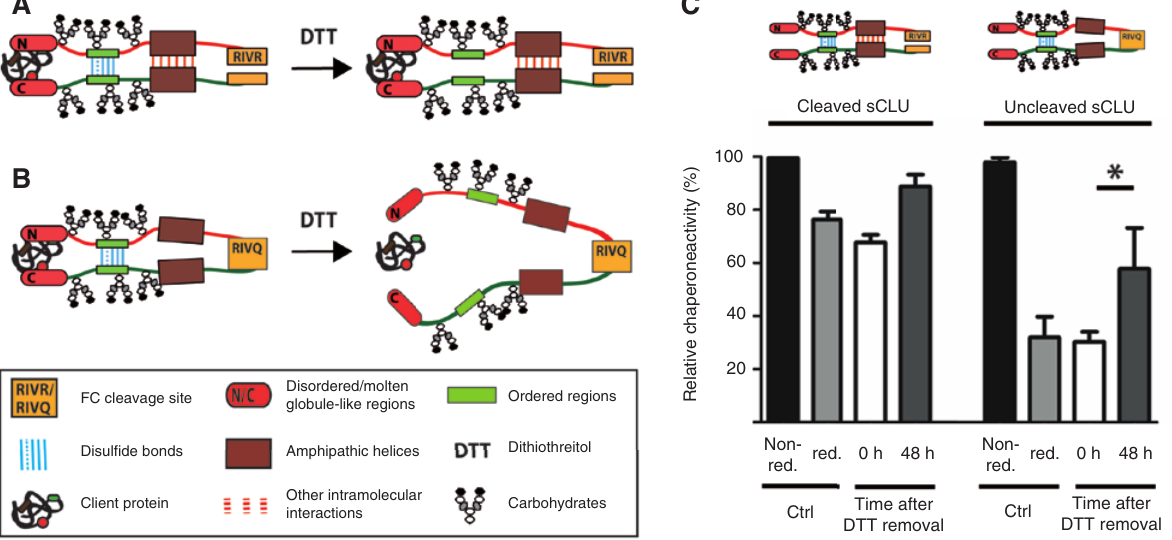
Figure 2: Schematic depiction of sCLU chaperone activity and hypothetical influence of structural elements. Fully maturated sCLU is stabilized by disulfide bonds and intramolecular interactions, such as hydrophobic interactions in the region of amphipathic helices (A). In contrast, artificial uncleaved sCLU relies on its disulfide bonds and therefore displays a high sensitivity towards reducing conditions (B). Preliminary data show that uncleaved sCLU partly regains its chaperone activity after removal of DTT within 48 h (C). The procedure of sCLU purification, DTT treatment and chaperone activity assay are in accordance with Rohne et al. (30). After 12 h of incubation with or without 40 mm DTT at 37 ° C upon gentle agitation, sCLU was subsequently used for chaperone activity assays (Ctrl reduc- ing and non-reducing) or DTT was substituted by PBS using a Vivaspin 4 5000 MWCO PES (Sartorius) at 4 ° C and used for chaperone activity assays subsequently or after 48 h at 4 ° C. All chaperone activity assays were performed in the presence of 5 mm DTT with Catalase being the client protein. Additionally, BSA was mixed with Catalase and served as a negative control to calculate the relative chaperone activity of sCLU as described by Rohne et al. (30). For evaluation, the data of two to three independent experiments, each with the mean of two to three measurements were used (unpaired t -test * p < 0.05). The error bars correspond to the mean ± standard